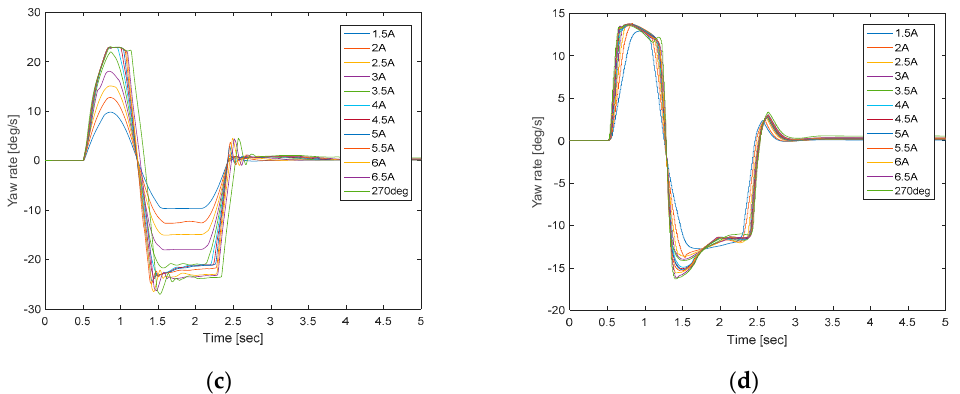
Figure 10. Yaw rate with a friction coefficient of 0.5 in the sine with dwell condition. ( a – d ) show the nominal yaw rate, open-loop control yaw rate, PID control yaw rate and closed-loop control yaw rate plots for the sine with dwell (SWD) condition on a pavement with an adhesion factor of 0.5.